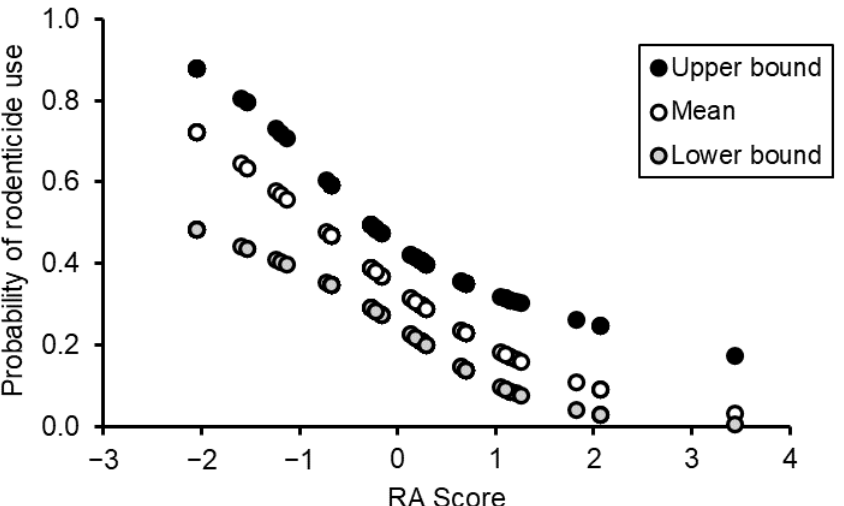
Figure 4. Probability of rodenticide use depending on rodent attitude (RA) scores of farmers. Mean refers to predicted value of mean response, lower bound refers to lower bound of 95% CI of mean, and upper bound refers to upper bound of 95% CI of mean; these values were determined from a GLM with binomial logit link function with RA score included as a covariate.